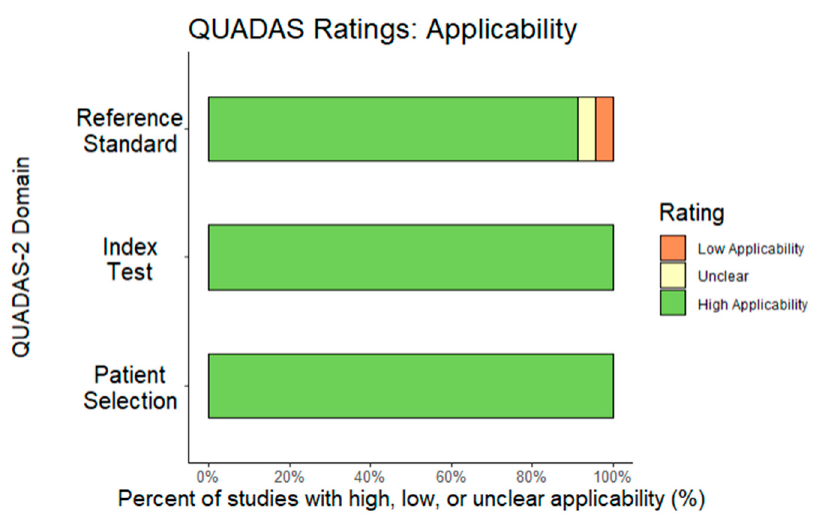
Figure 2. QUADAS Risk of Bias report.